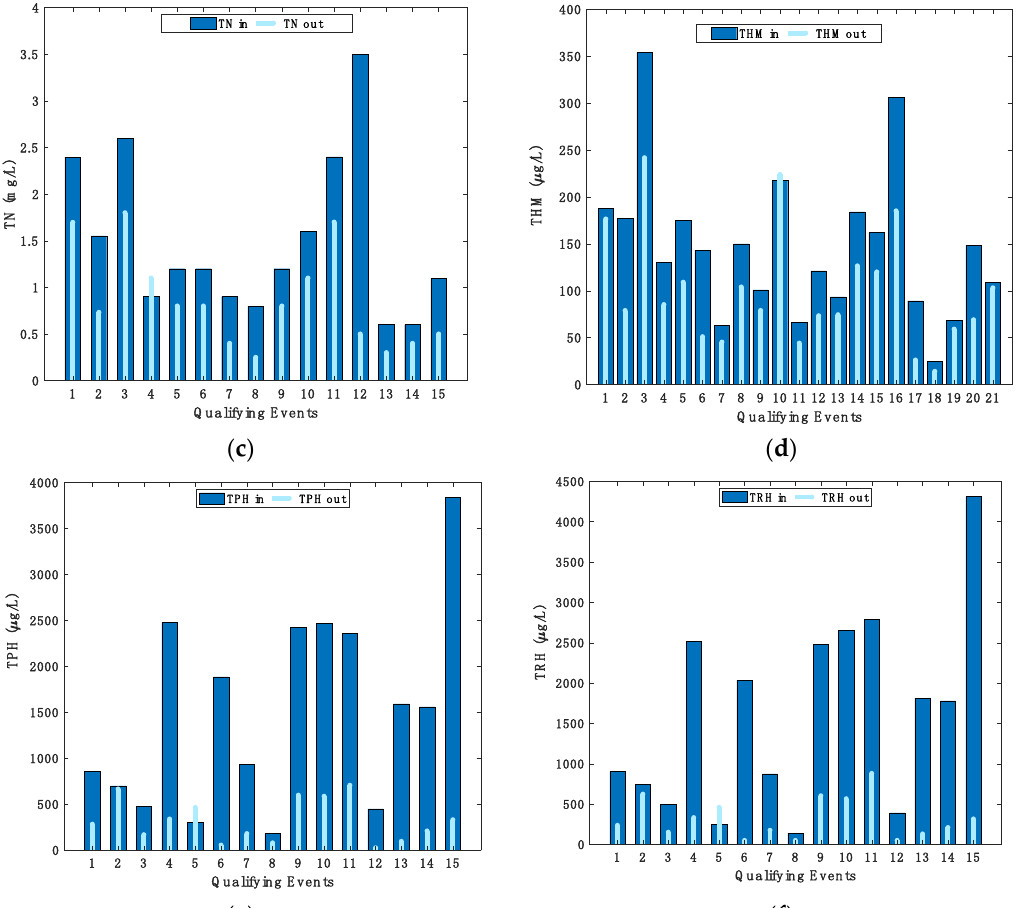
Figure 8. Interleaved bar plots for all pollutants: ( a ) TSS; ( b ) TP; ( c ) TN; ( d ) THM; ( e ) TPH; ( f ) TRH.